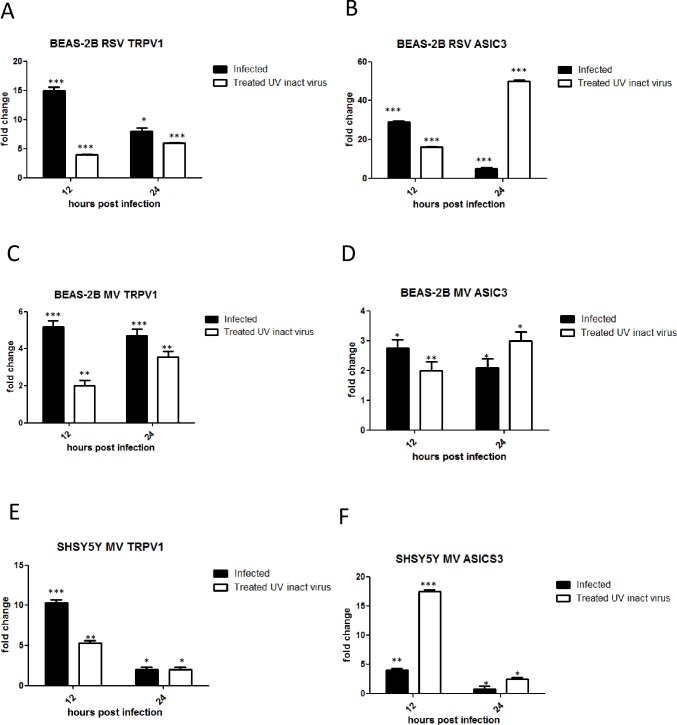
UV inactivated virus preparations up-regulate TRPV1 and ASICS3 mRNA levels.BEAS-2B cells were infected with RSV (MOI 0.1) or MV (MOI 1), or were treated with equivalent virus preparations that had been UV inactivated. SHSY5Y were also infected with MV or treated with UV-inactivated virus. (A, B, C and D) BEAS-2B cells, (E) and (F) SHSY5Y cells. (A) RSV TRPV1, (B) RSV ASIC3, (C) and (E) MV TRPV1, (D) and (F) MV ASIC3. Data is presented as relative fold change to TRPV1 and ASIC3 mRNA levels relative to uninfected/untreated control cultures.